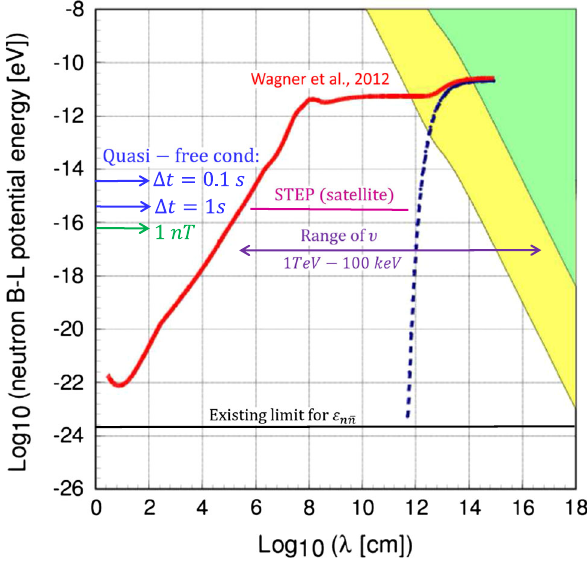
Fig. 2 Potential energy V n of the neutron in B − L field of Sun and Earth (see text for explanations). The region of potentials V n above the red curve is excluded by torsion-balance experiment limits [34]. The claimed sensitivity limit of the canceled space-mission project STEP [38] is also shown for